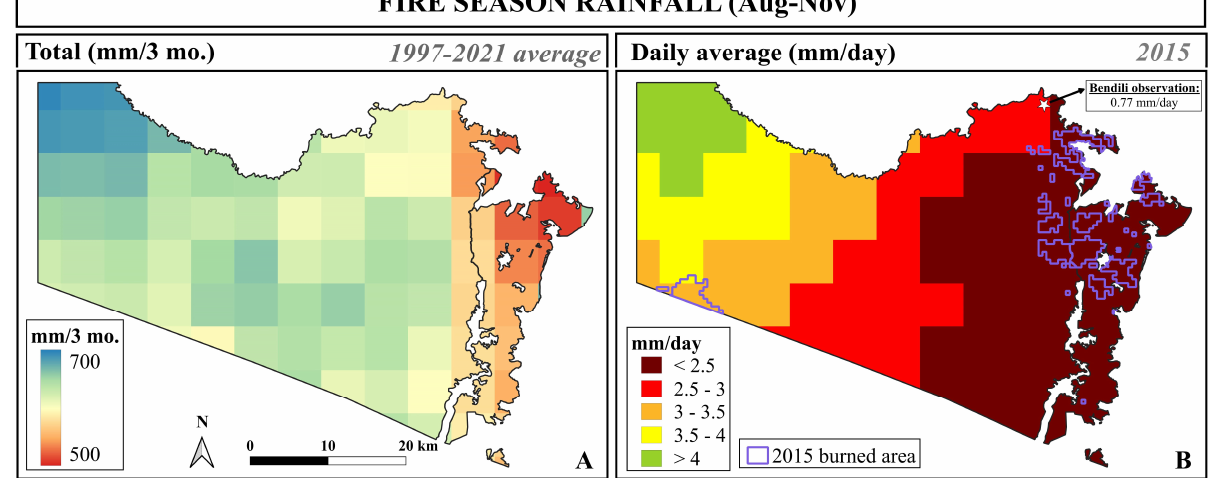
Figure 6. Per-pixel averages (1997–2021) of total rainfall ( A ) and daily average rainfall vs. burned area in 2015 ( B ) during the standard fire season (August–November) within Kutai National Park. Rainfall estimates from CHIRPS Pentad; burned area estimates from MCD64A1.